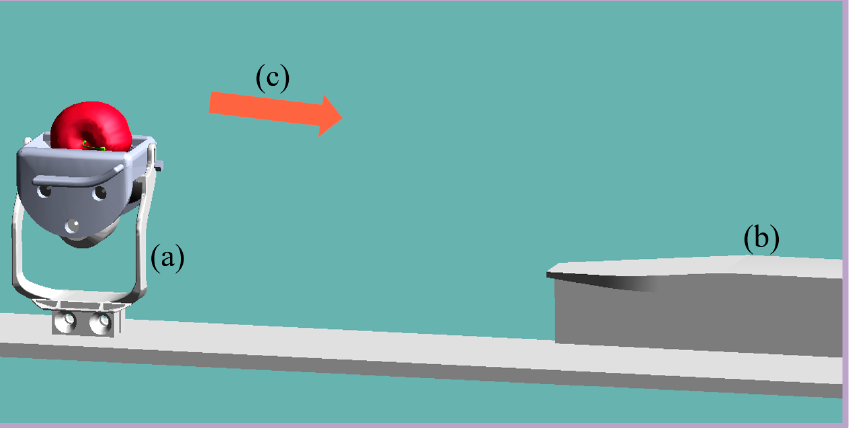
Figure 11. Simulation model diagram of ADAMS: ( a ) grading cup and sweet cherry; ( b ) external friction platform; (c) movement direction.